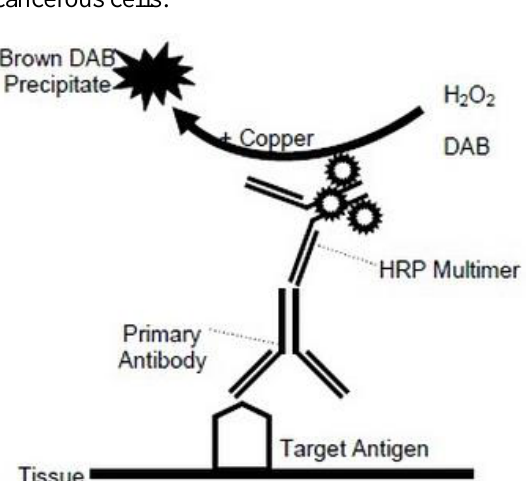
Fig. 1. UltraView Universal DAB Detection Kit Reaction.